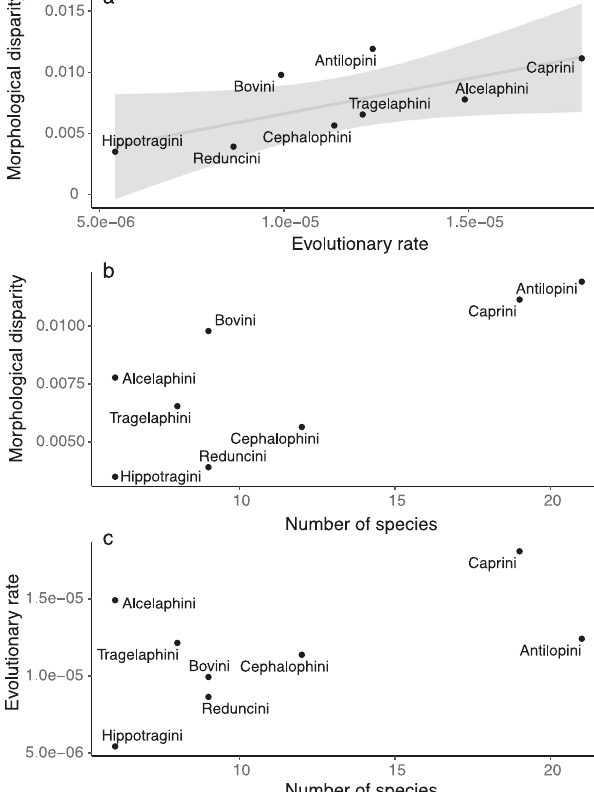
Fig. 5 Morphological disparity in relation to evolutionary rates and species richness among tribes. a Disparity and rates of morphological change are strongly correlated (though the pairwise differences among tribes are largely nonsigni fi cant, see the text). However, neither disparity nor rates are signi fi cantly correlated with clade richness ( b , c ), implying that cranial shape is not a major determinant of speciation in